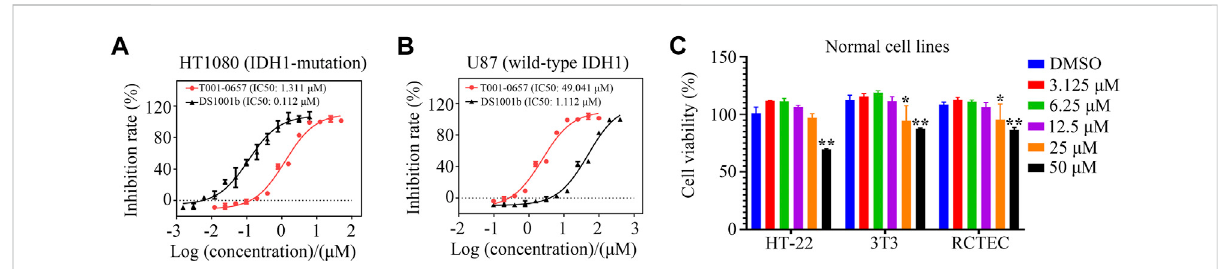
FIGURE 3 T001-0657suppresses IDH1 activity invitro. (A) T001-0657inhibits theHT1080 cell proliferation, with an IC 50 value of1.311 μ M. (B) T001-0657